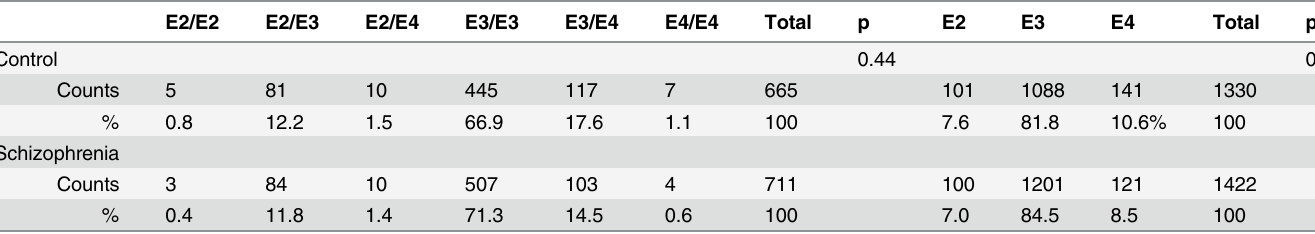
Table 2. Genotype and allele frequencies of APOE2, E3 and E4 in this